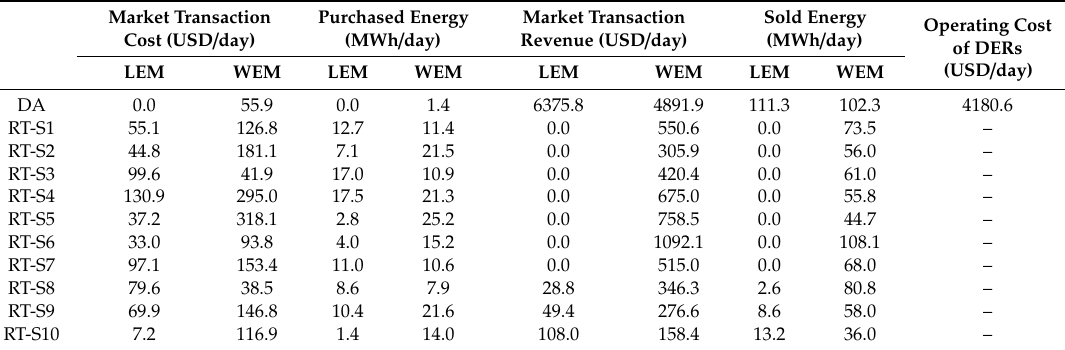
Table 8. AG’s cost, revenue, and traded energy during the whole day.